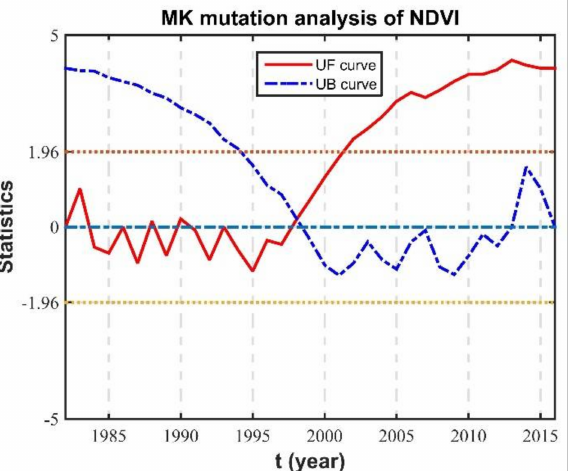
Figure 5. Mann–Kendall mutation test result of NDVI in the SAYR from 1982 to 2016.